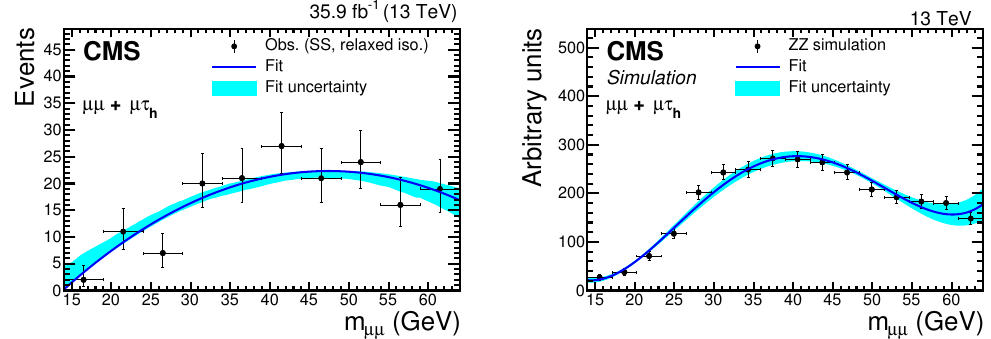
Figure 2 . Parameterization of the shape of the background with misidenti(cid:12)ed (cid:28) leptons (left) and Z pair production background (right) in the (cid:22)(cid:22) + (cid:22)(cid:28) h (cid:12)nal state. The points for the ZZ background represent events selected in simulation, whereas they correspond to observed data events in the SS region with relaxed isolation for the background with misidenti(cid:12)ed (cid:28)